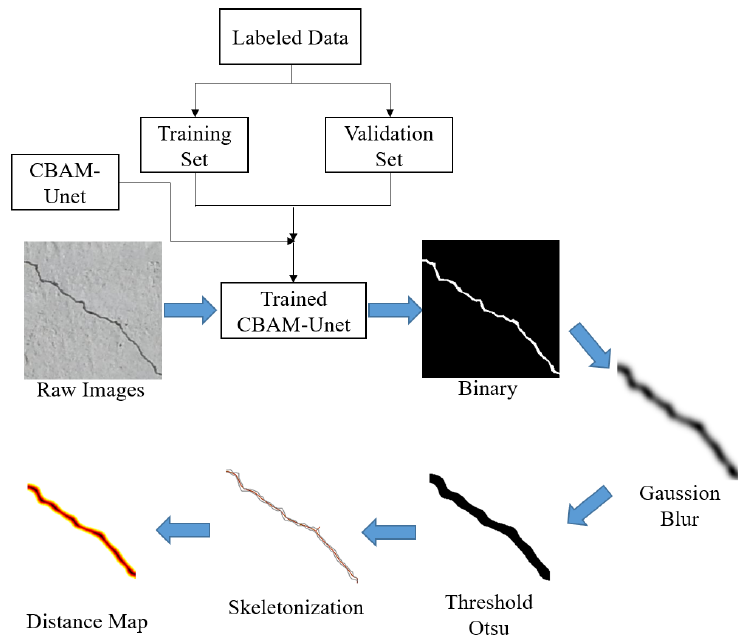
Figure 1. Extraction of fracture features based on